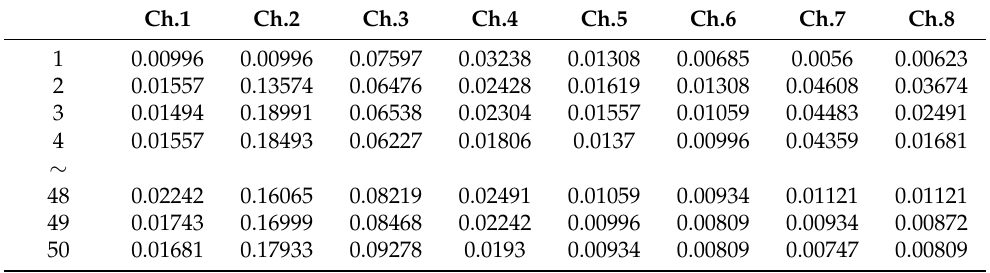
Table 3. One set of normalized EMG data.